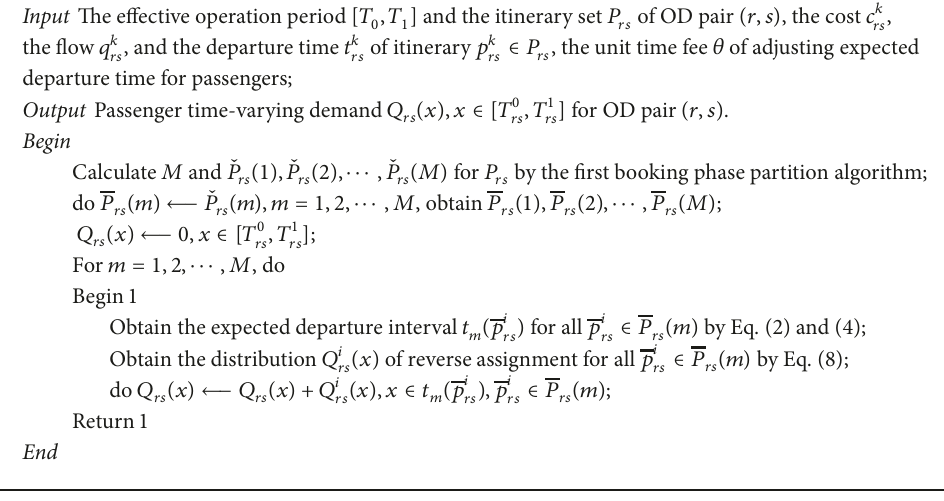
Algorithm 3: Single Booking Phase Reverse Assignment algorithm.